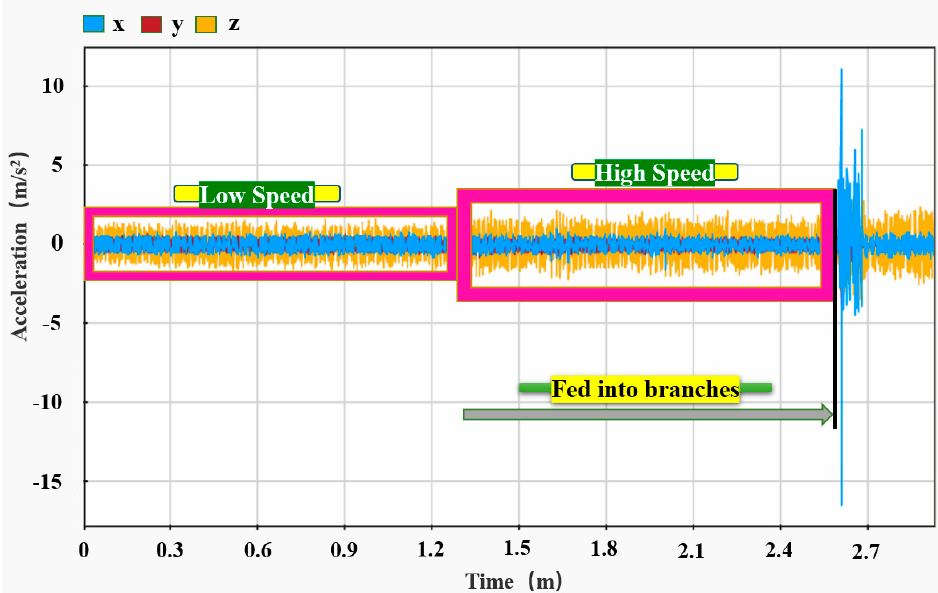
Figure 19. Frequency diagram of the static no-load and crushing time of the support rod: ( a ) three- way time–frequency diagram; ( b ) time–frequency diagram in the x-direction; ( c ) time–frequency diagram in the y-direction; ( d ) time–frequency diagram in the